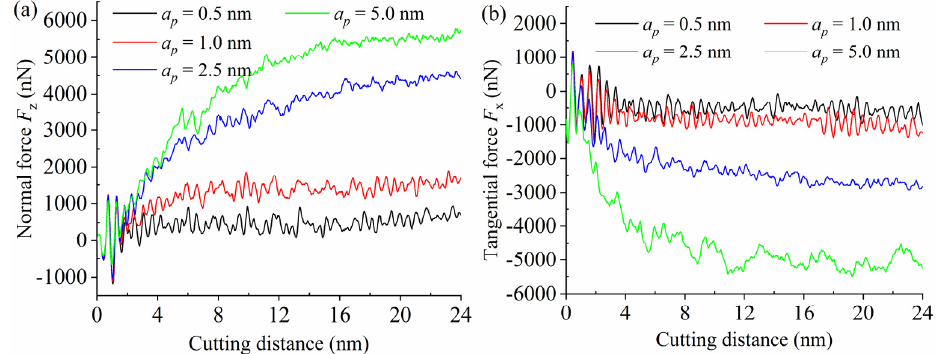
Figure 8. The variations of ( a ) normal force Fz and ( b ) tangential force Fx with different undeformed cutting thicknesses.